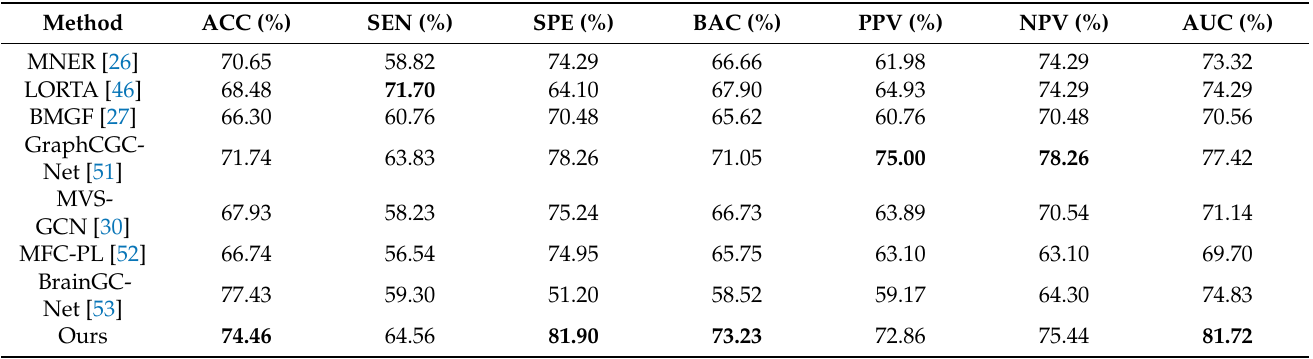
Figure 3. Frequencies of the optimal p values selected in an inner loop for the four different methods based on a t -test with p = { 0.01,0.05,0.001,0.005}. The horizontal axis indicates the multiple thresh- olds for the different methods, and the vertical coordinates indicate the frequencies of occurrence of the different thresholds. Table 3. Classification results (mean ± standard deviation) of six methods in the task of ASD vs. NC classification, with best results shown in